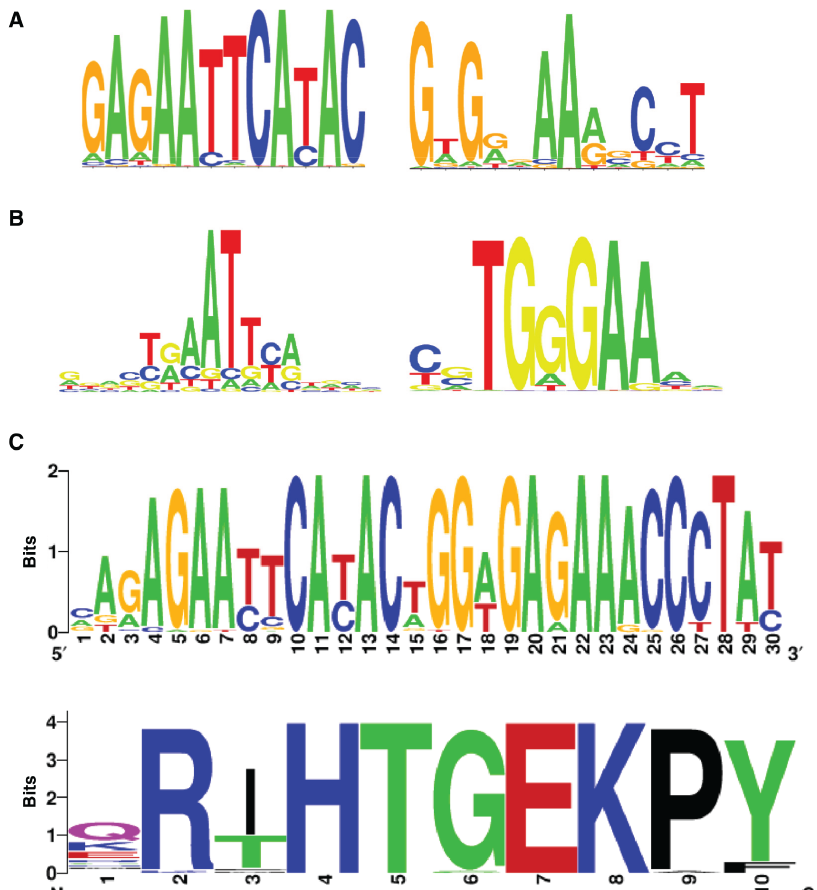
Figure 3: Motif analysis of the SUMO binding regions. (A) Two de novo motifs uncovered by motif discovery using HOMER [14] in SUMO2/3 ChIP-seq data, visualised by us- ing WebLogo [15]. The left motif is similar to SOX18 ’ s binding motif, and the right motif is similar to RBPJ1 ’ s binding mo- tif. (B) SOX18 and RBPJ1 binding motifs which were identified by HOMER as the known motifs being similar to the two de novo motifs in (A), created by Seq2Logo [16]. (C) The logo graphs of the DNA (top) and protein (bottom) sequences as- sociated with the 44 “ SOX18-2bp-RBPJ1 ” motif matching sites found in the SUMO ChIP-seq data. Two more nucleotides in the up- and down-stream of the matching sites were also included, because they belong to the same DNA translation frame as the first and last nucleotide within the matching sites according to the genes in which they are